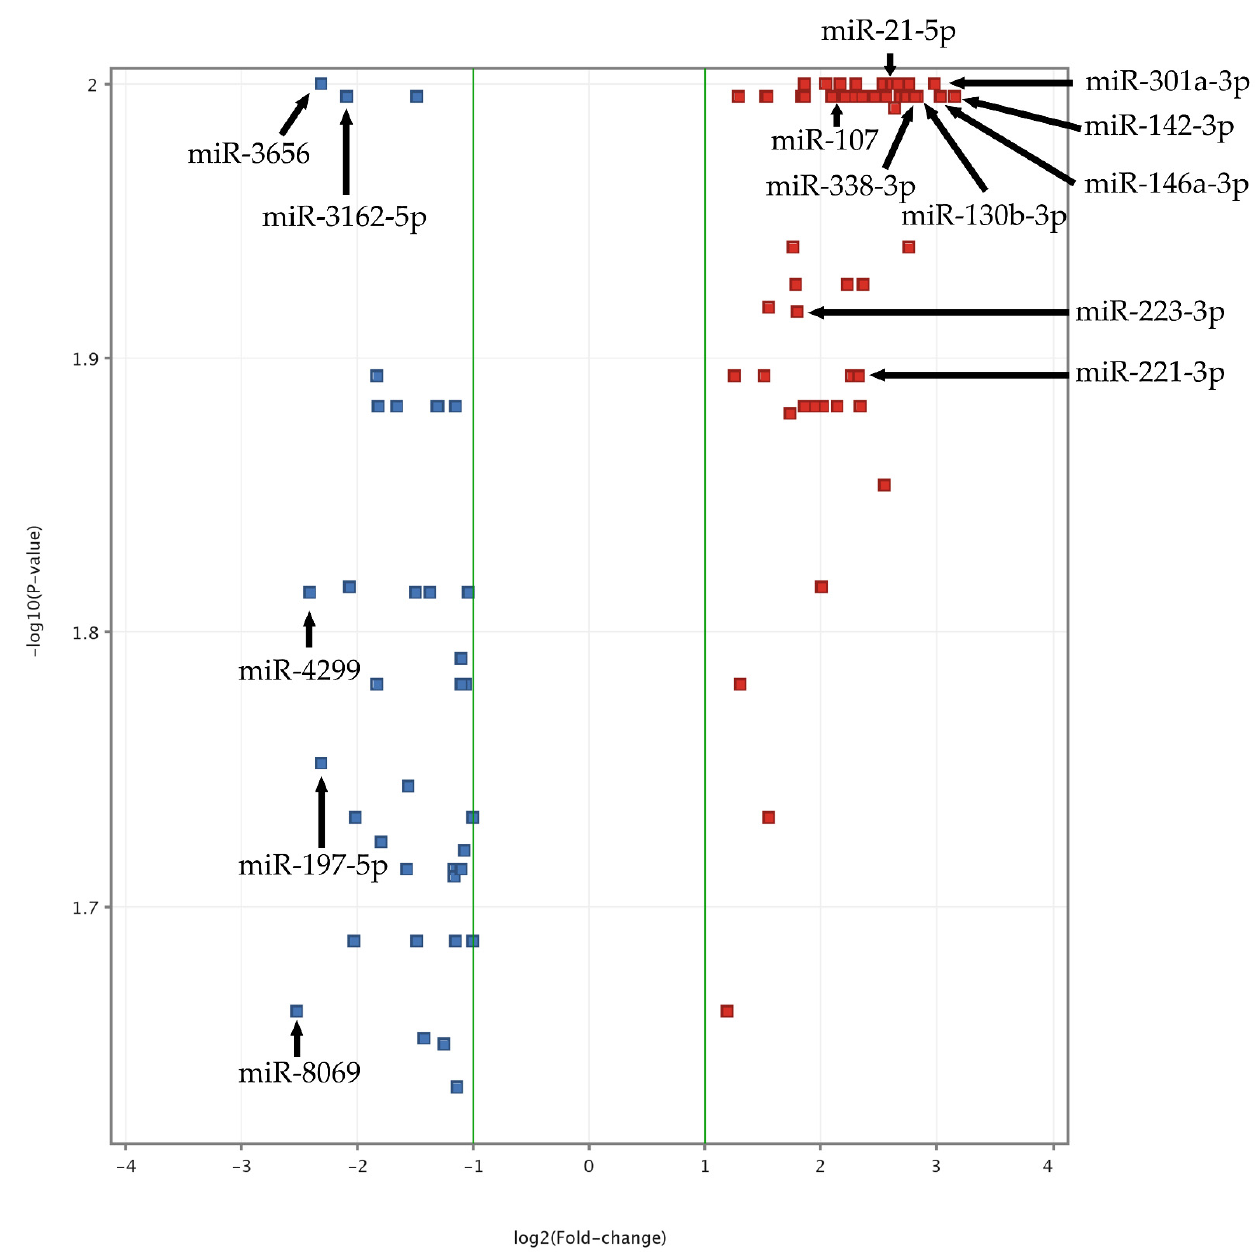
Figure 1. Volcano plot of ACS vs. Control miRNA microarray analysis. The data for all miRNAs are plotted as log 2 (Fold- change) vs. the − log 10 ( p -value). A fold-change threshold is presented as green lines. The 5 most upregulated (miR-301a-3p, miR-142-3p, miR-146a-3p, miR-130b-3p, miR-338-3p) and downregulated (miR-8069, miR-4299, miR-3656, miR-197-5p, miR-3162-5p) miRNAs, selected based on fold-change values, are indicated by black arrows. Furthermore, statistically significant miRNAs, validated by qRT-PCR, are also presented (miR-142-3p, miR-107, miR-338-3p, miR-223-3p, miR-21-5p, miR-130b-3p, miR-301a-3p, and miR-221-3p). The altered expressed miRNAs between studied groups with the highest significance (the lowest p -value) are located at the top of the plot. MiRNAs demonstrating large fold-change values are plotted outside of the vertical threshold lines. A greater distance from the center indicates a greater fold-change. Red square points on the plot represent upregulated miRNAs, whereas blue square points on plots represent downregulated miRNAs.